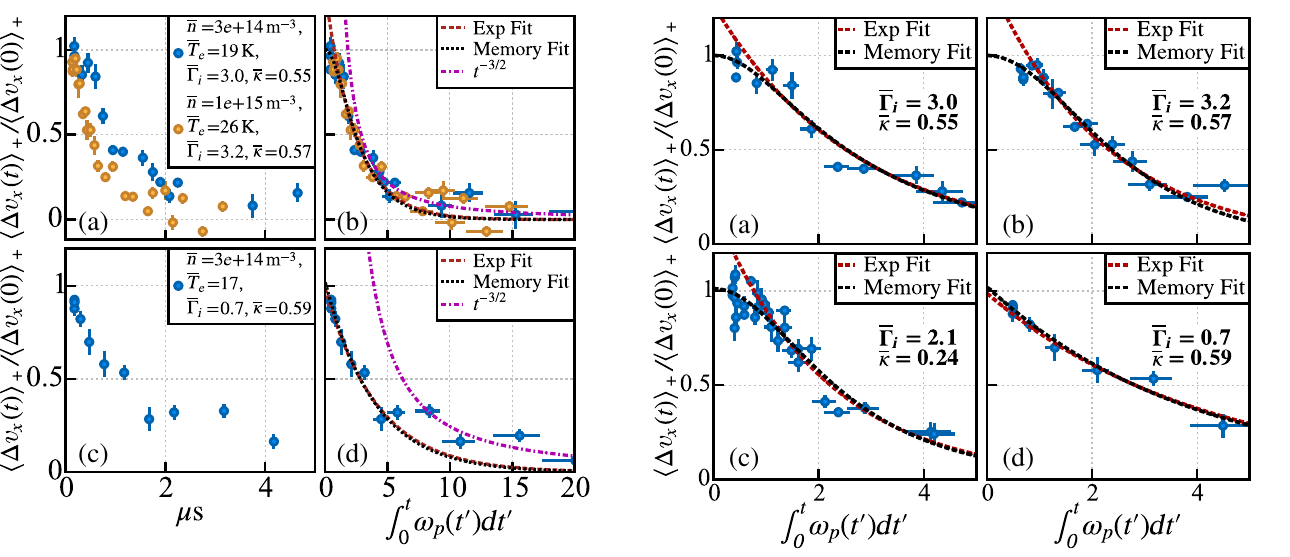
= h Δ v 0 Þi plotted versus time for x ð þ þ = h Δ v 0 Þi with ω p for plasmas of different x ð þ þ ¯ Γ ¯ κ . Panels (c) and i and